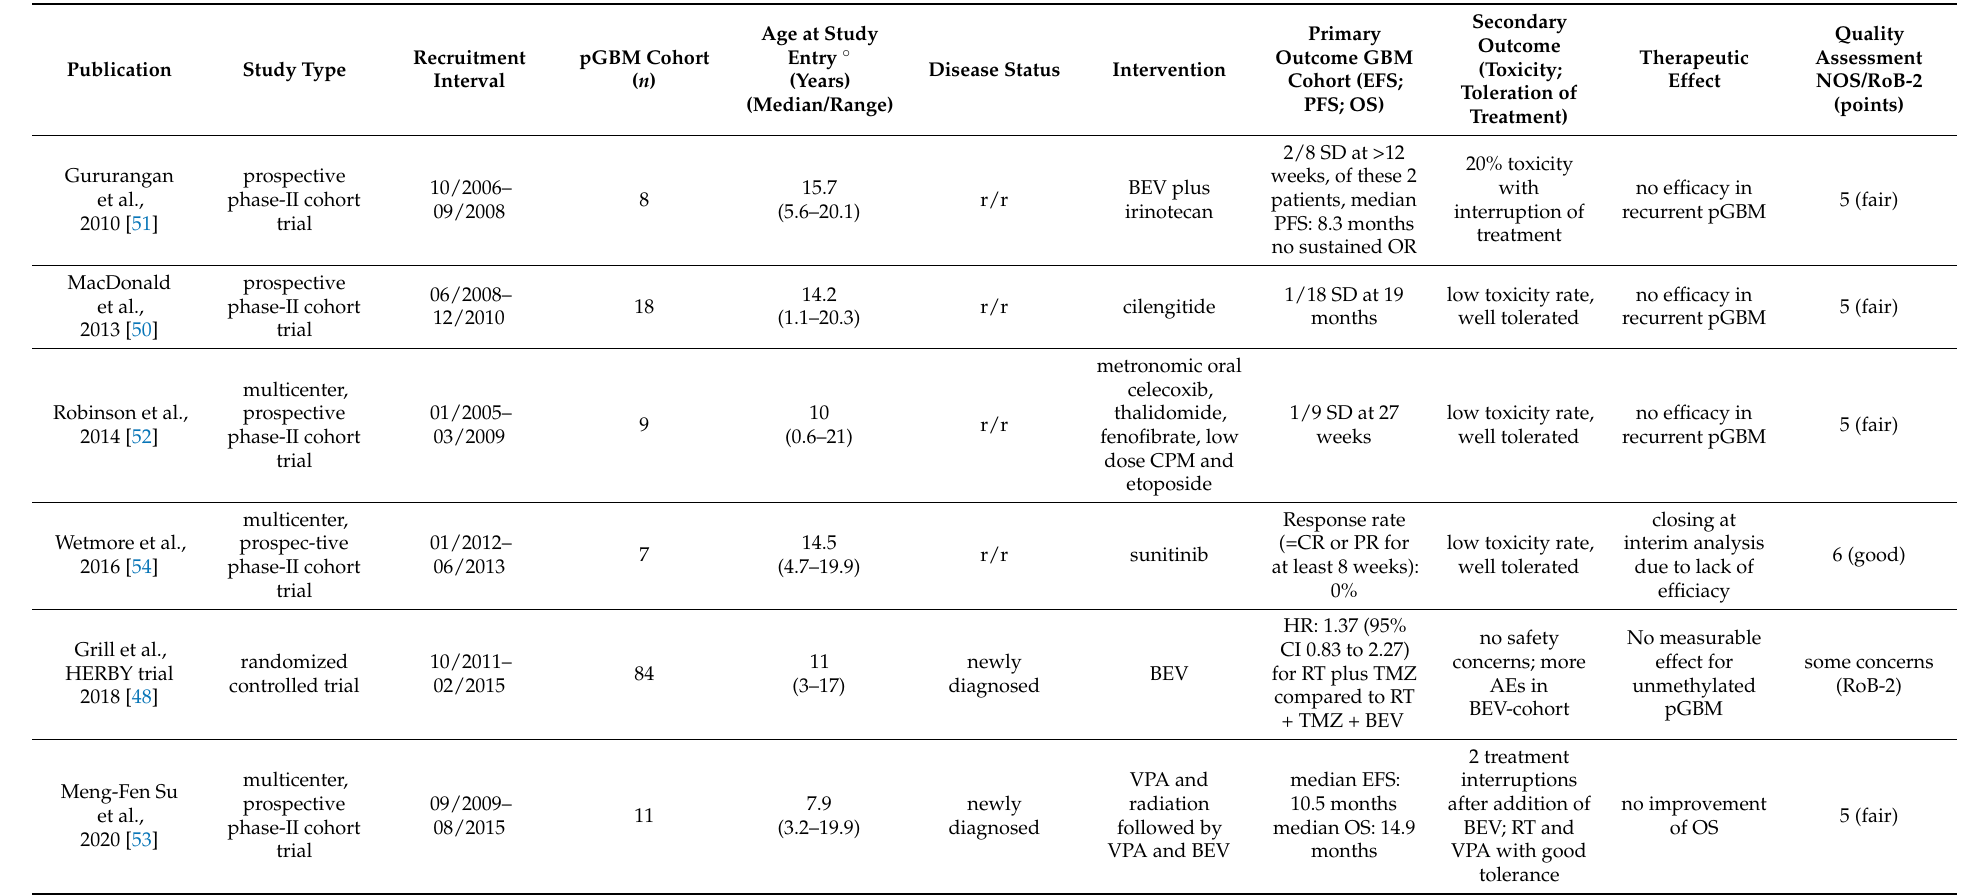
Table 2. Results of analyzed studies with objectifiable baseline